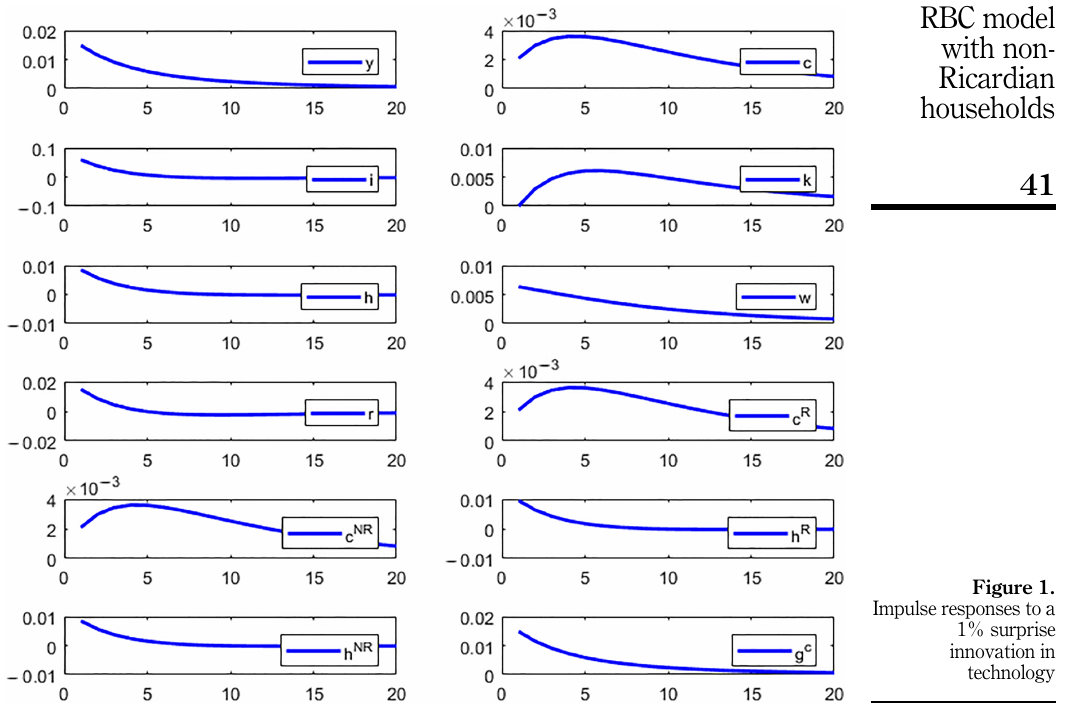
Figure 1. Impulse responses to a 1% surprise innovation